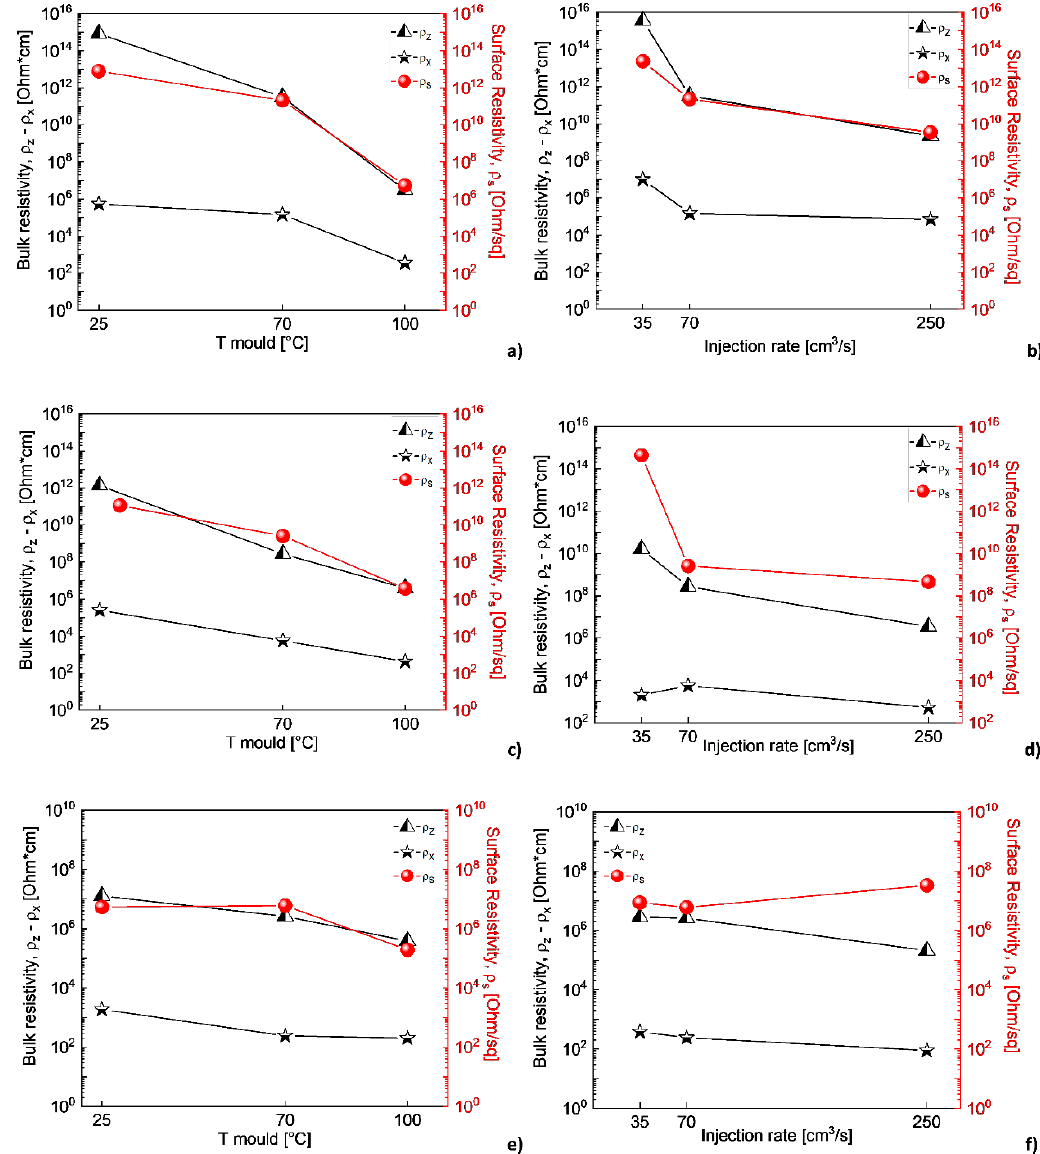
Figure 5. Effect of the mold temperature and injection rate on the electrical bulk and surface resistivity of: 2%-MWCNT nanocomposites, injection rate 70 cm 3 /s, and ( a ) mold temperature 70 °C ( b ); 3%-MWCNT nanocomposites, injection rate 70 cm 3 /s ( c ) and mold temperature 70 °C ( d ); 4%-MWCNT nanocomposites, injection rate 70 cm 3 /s ( e ) and mold temperature 70 °C ( f ).